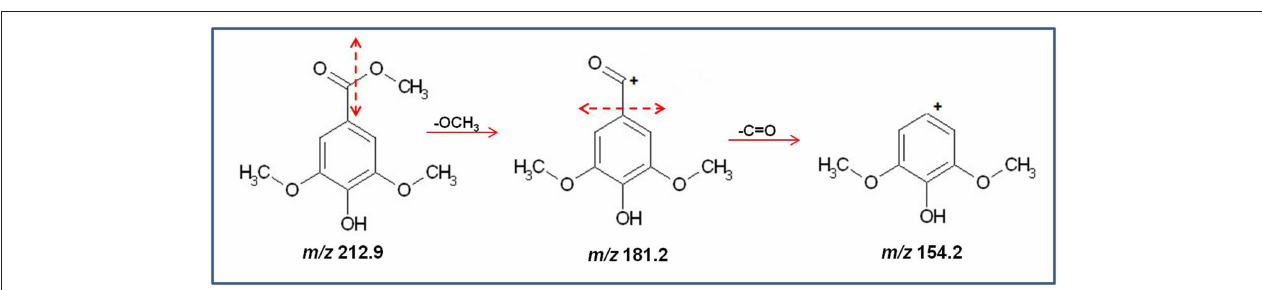
FIGURE 4 | Schematic diagram of the production of major fragments from Methyl Syringate ( m/z 212.9).